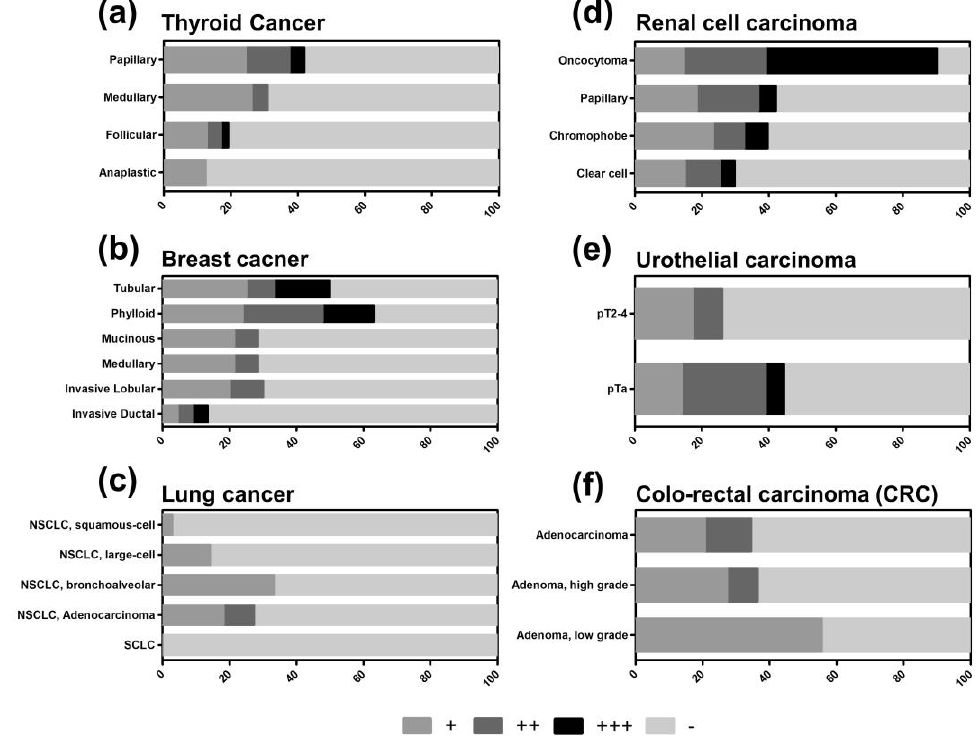
Figure 2. Differential expression of thioredoxin interacting protein (TXNIP) in selected tumor types and subtypes on multi-tumor TMA. ( a ) Thyroid cancer subtypes, ( b ) breast cancer subtypes, ( c ) lung cancer including non-small cell lung cancer (NSCLC) subtypes and small-cell lung cancer (SCLC), ( d ) renal cell cancer, ( e ) urothelial cancer (pTa = non-invasive papillary carcinoma, pT2-4 = invasive carcinoma), and ( f ) colo-rectal cancer (CRC). ‘−‘ = negative, ‘+’ = weak, ‘++’ = moderate, and ‘+++’ = strong TXNIP expression.